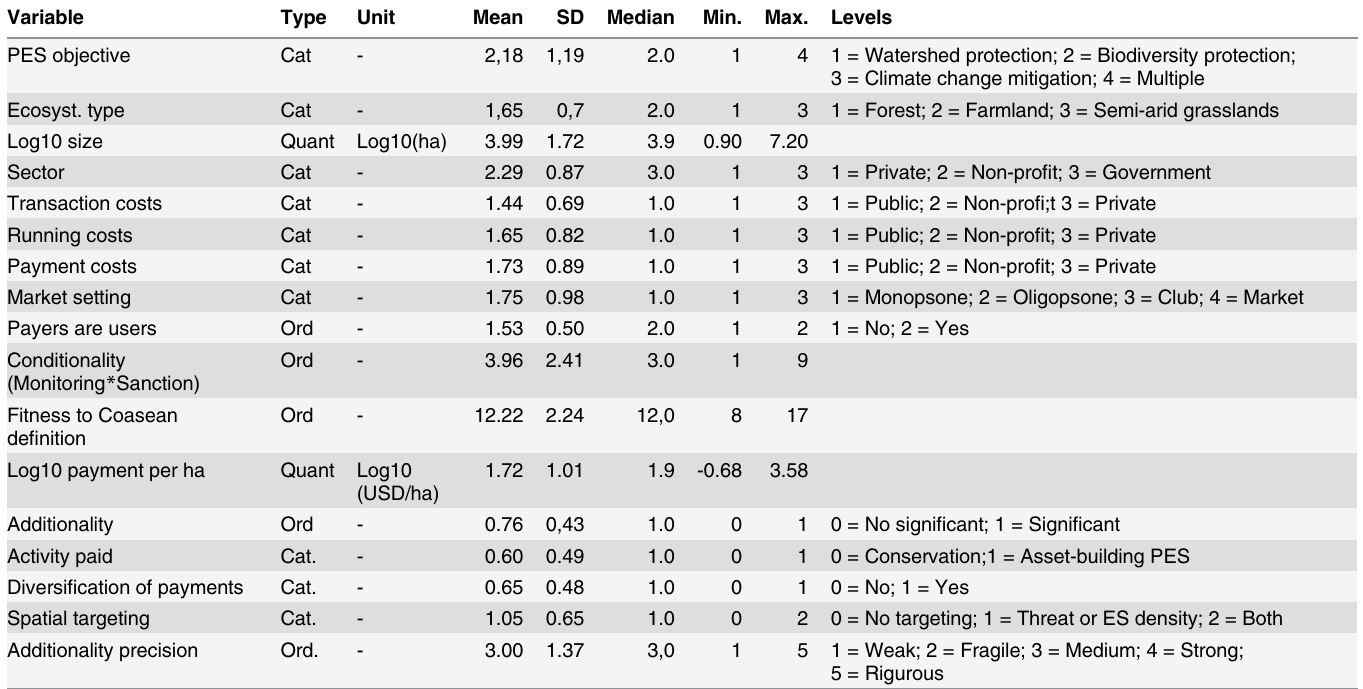
Table 2. Descriptive statistics for our main